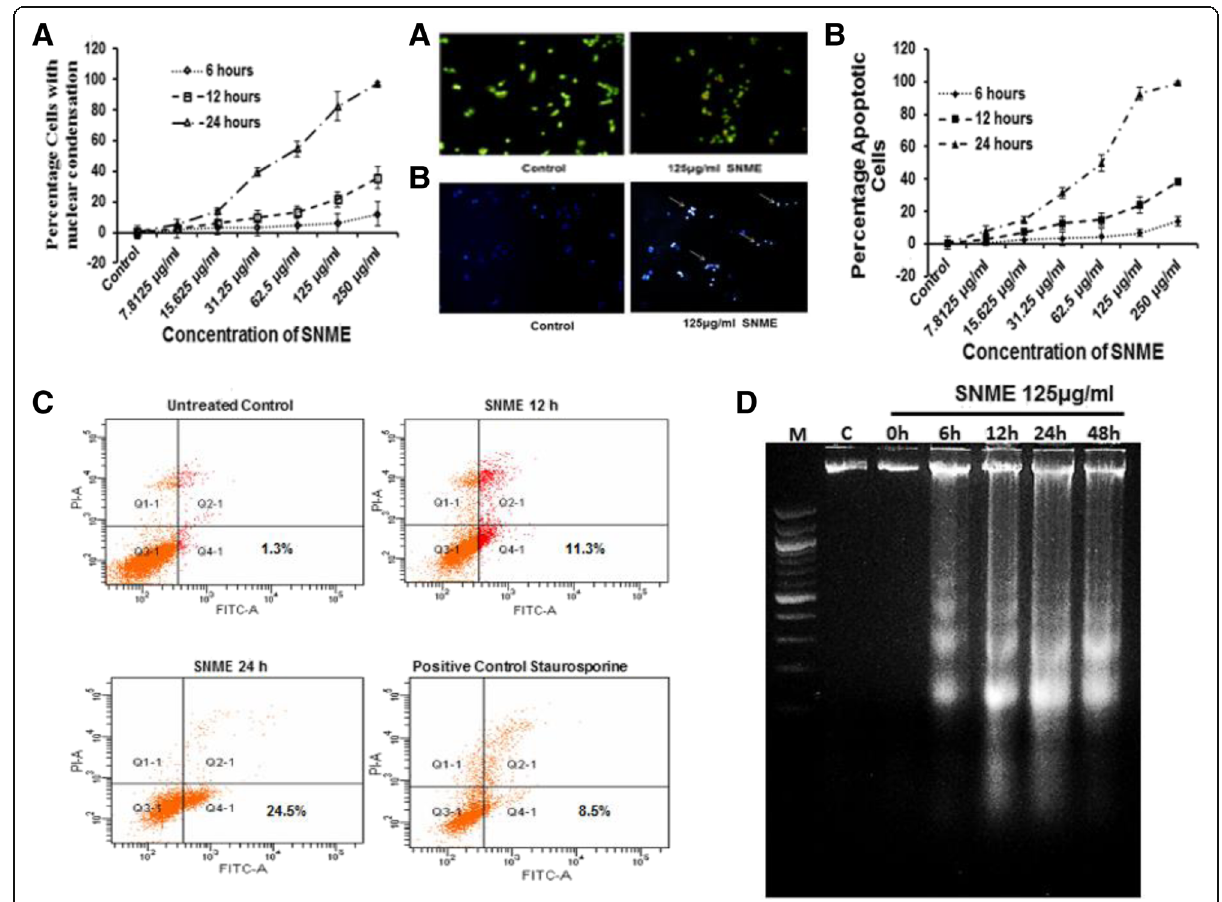
Fig. 4 a , Apoptotic potential of SNME on NCI/ADR-RES cells. Cells were treated with 7.8125, 15.625, 31.25, 62.5, 125 and 250 μ g/ml of methanolic extract for 6, 12 and 24 h, stained with ethidium bromide-acridine orange. Control cells were maintained in the vehicle for the indicated time periods. Results are represented as mean ± SEM of three assays. Representative microscopic image showing ethidium bromide – acridine orange stained apoptotic cells after treatment with 125 μ g/ml SNME on NCI/ADR-RES cells. b , Nuclear condensation studies of SNME on NCI/ADR-RES cells. Cells were treated with 7.8125, 15.625, 31.25, 62.5, 125 and 250 μ g/ml of methanolic extract for 6, 12 and 24 h, stained with Hoescht. The number of bright blue condensed spots indicating apoptotic cells with condensed chromatin increases with Solanum nigrum treatment in a time and concentration dependent manner. Control cells were maintained in the vehicle for the indicated time periods. Results are represented as mean ± SEM of three assays. Representative microscopic image showing nuclear condensation ( → ) in Hoescht stained apoptotic cells after treatment with 125 μ g/ml SNME on NCI/ADR-RES cells. c , SNME induces apoptosis in NCI/ADR-RES cell. FITC-conjugated annexin binding to phosphatidyl